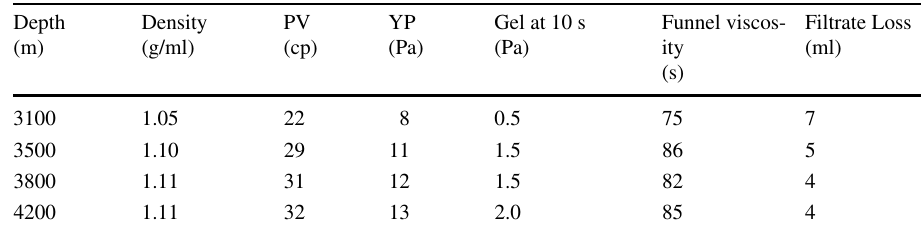
Table 12 Mud properties at various depths during drilling of well No. 6